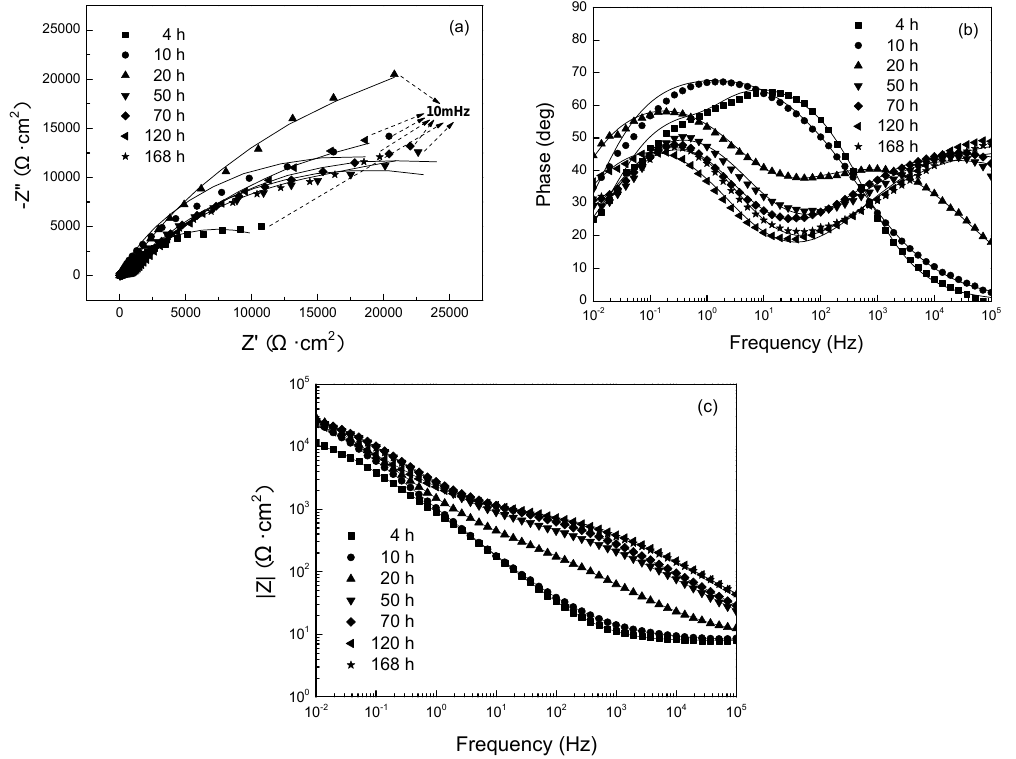
Figure 3. EIS evolution of 304 SS with polarization at − 0.80 V in sea water. Nyquist plot ( a ), Bode plot ( b , c ), in which symbols are measured data, lines are simulated.